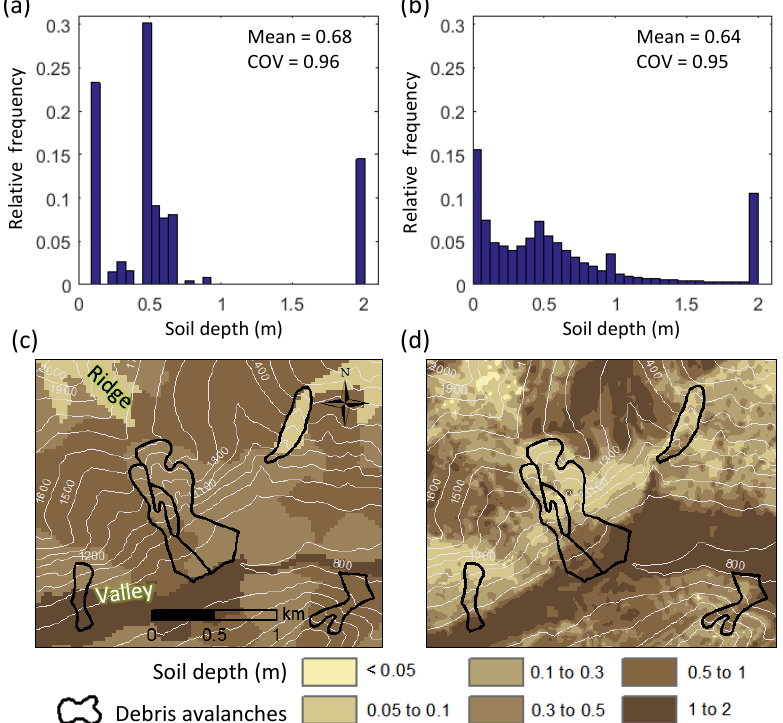
Figure 7. Sample illustration of the soil evolution model. Relative histograms of soil depths within NOCA: (a) SSURGO-SD and (b) the mode of M-SD, with respective spatial mean and coefficient of variation (COV). Mapped soil depth, with mapped debris avalanches outlined in black; contours are at 100m for (c) SSURGO-SD and (d) M-SD.